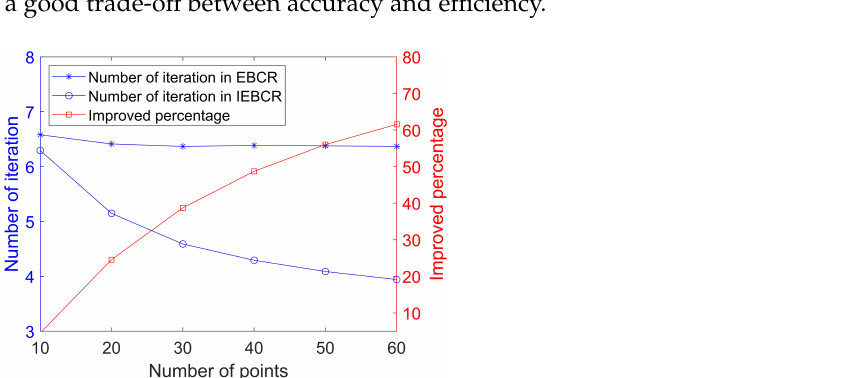
Figure 14. The average number of iterations in ERCR and IEBCR and the improved curve in efficiency.